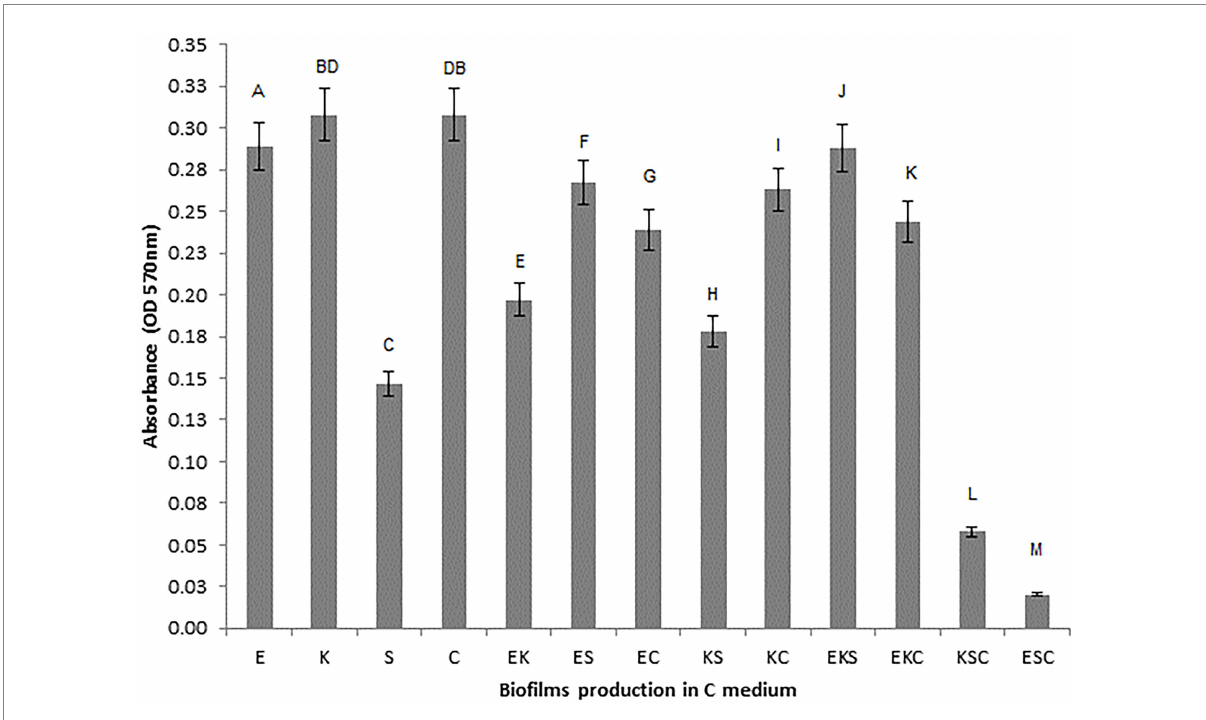
FIGURE 1 Growth control of the single-and the mixed- biofilms in polystyrene microtiter plates: (E) E. cloacae , (K) K. oxytoca , (S) S. odorifera , (C) S. cerevisiae , (EK) E. cloacae/K. oxytoca , (ES) E. cloacae/S. odorifera , (EC) E. cloacae/S. cerevisiae , (KS) K. oxytoca/S. odorifera , (KC) K. oxytoca/S. cerevisiae , (EKS) E. cloacae/K. oxytoca/S.odorifera , (EKC) E. cloacae/K. oxytoca/S. cerevisiae , (KSC) K. oxytoca/S. odorifera/S. cerevisiae , (ESC) E. cloacae/S. odorifera/S. cerevisiae . All results are expressed as the mean ± SE. The statistical test was based on Wilcoxon’s test. Different capital letters above means indicate significant differences among biofilms at a threshold of p <